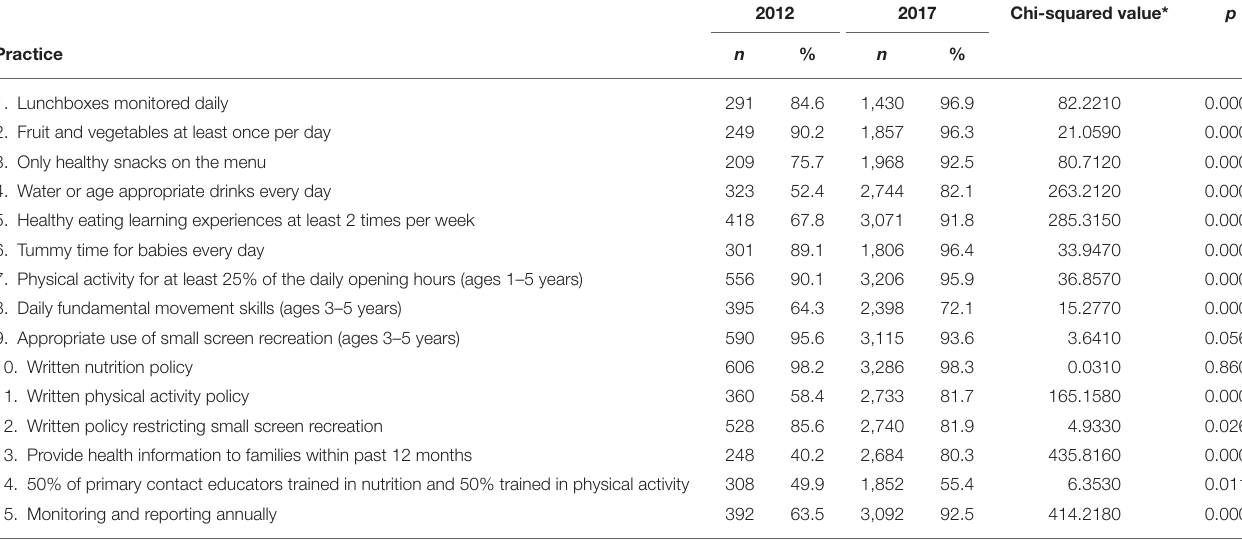
TABLE 2 | Practice achievement over